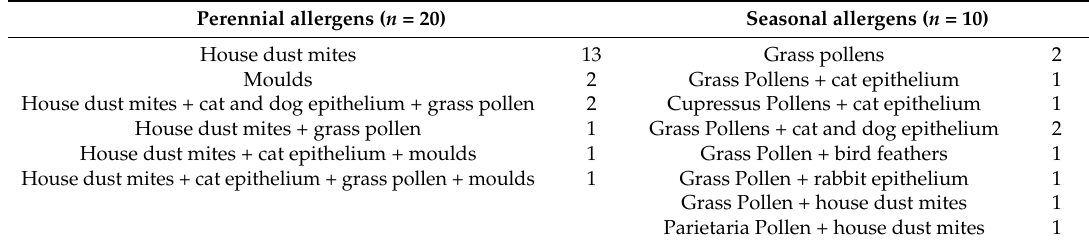
Table 2. Allergen detected by skin prick